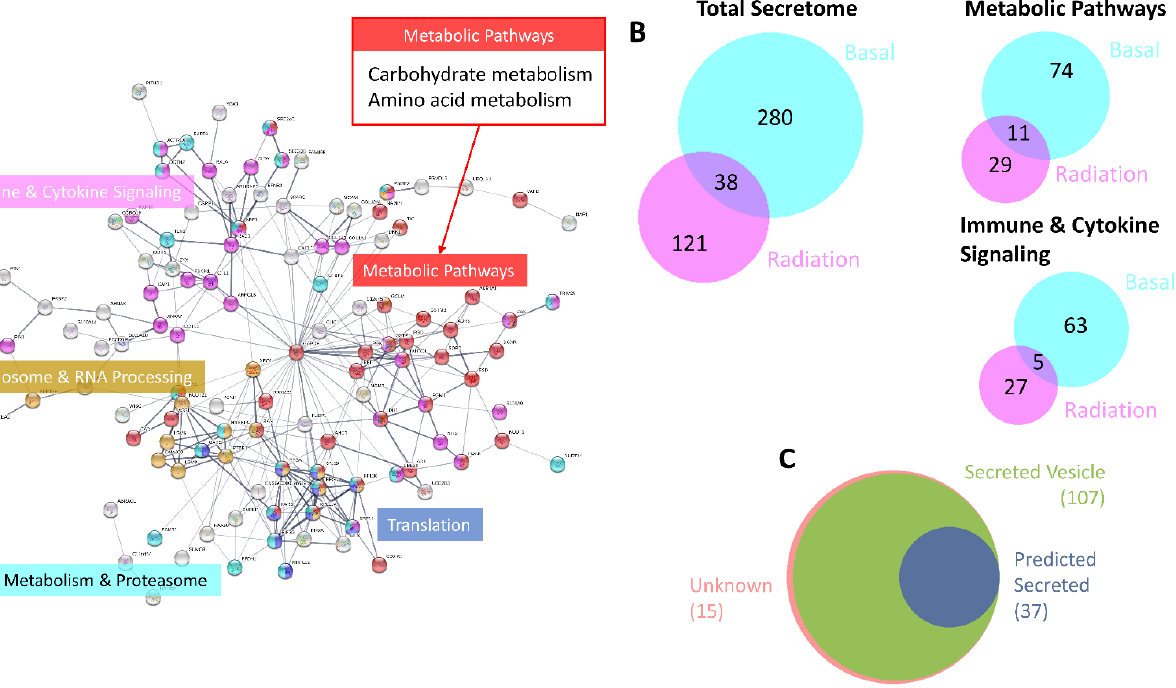
Figure 3. Characterisation of radiation-induced MCF-7 secretome. ( A ) Functional protein association network of the subset of 120 proteins with known interactions from the total number of 159 secreted proteins at 24 h with at least a 50% increase in secretion level following 2 Gy of radiation compared with 24 h untreated controls. Graph produced in STRING based on co-expression and reported STRING interactions with high-confidence interaction score (0.7), clustered using the Markov Clustering algorithm. Significantly enriched pathways from the KEGG [41] and Reactome [42,43] databases are highlighted and labelled (lists of proteins in each pathway are provided in Supplementary Table S4). ( B ) Venn diagrams showing the overlap in secreted proteins between the basal secretome and the radiation-induced secretome in respect of all secreted proteins and enriched pathways in both secretome profiles. ( C ) Venn diagram showing proportions of proteins identified in the radiation-induced secretome and their reported/predicted method of secretion; (pink) unknown, (green) secreted in exosomes/microvesicles (ExoCarta [47] and Vesiclepedia [48]), and (blue) directly secreted (Human Protein Atlas [49], SignalP [50], Phobius [51] and SPOCTOPUS [52]).